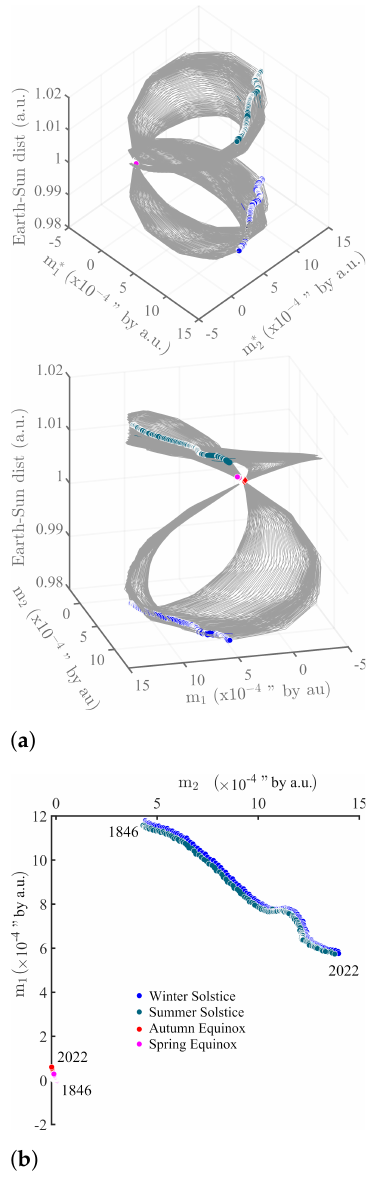
Figure 6. Drift of equinoxes and solstices since 1846 with the new parameters m ∗ diagram for the couple of coordinates ( m ∗ of time. ( b ) Projection of the drift of equinoxes and solstices from 1846 to the present in the ( m ∗